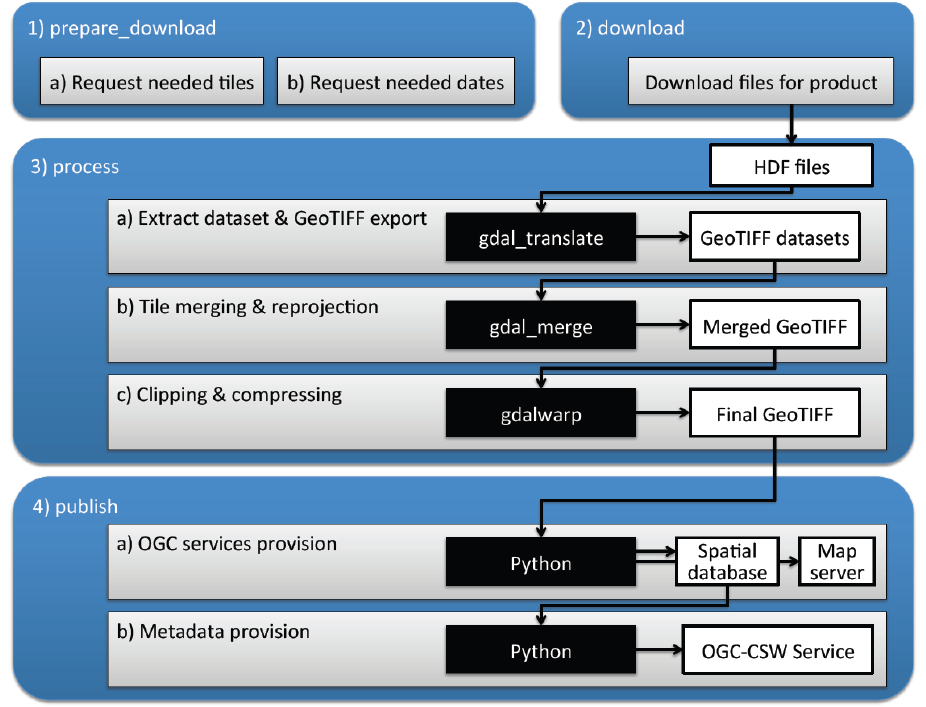
Figure 4. Processing chain for the integration of MODIS